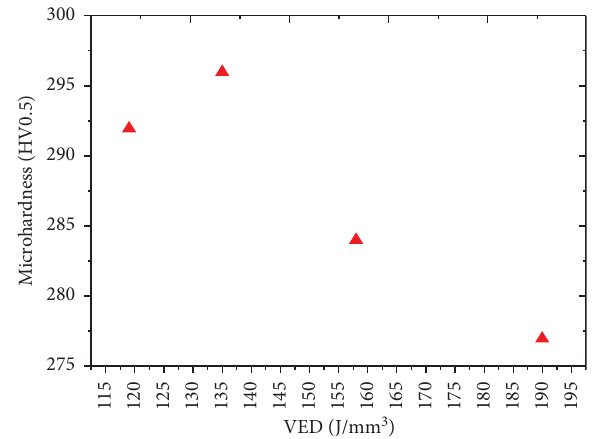
Figure 9: Microhardness for samples with volumetric energy